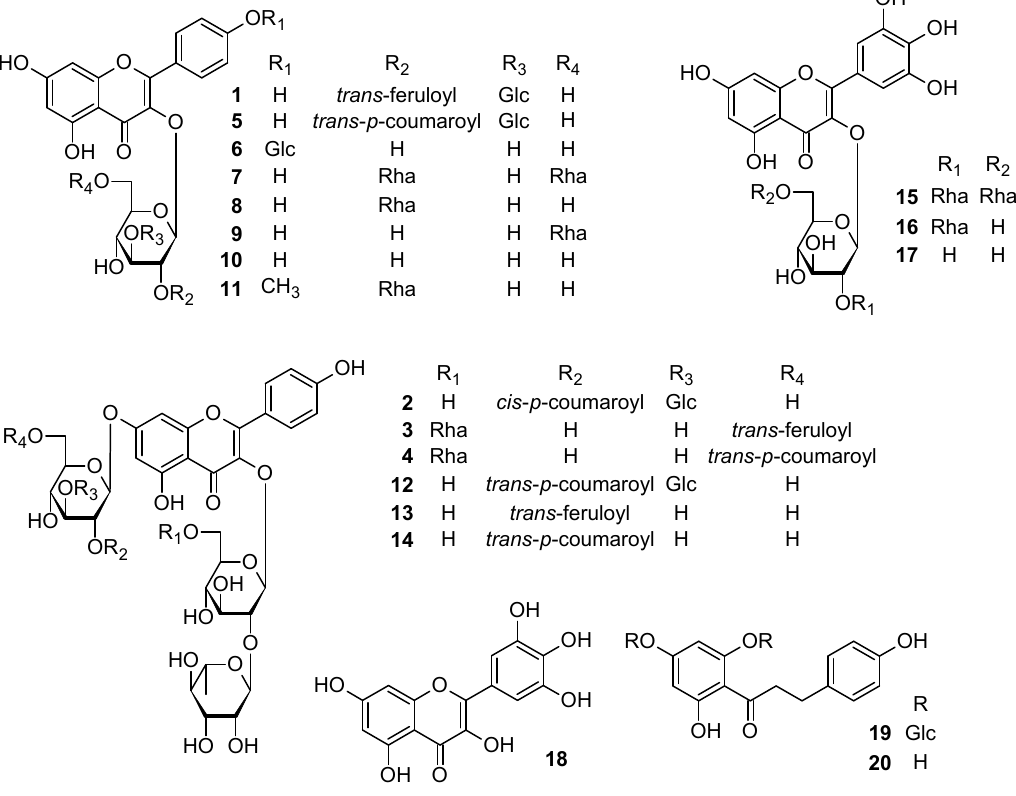
Figure 1. Compounds 1 – 20 isolated from Cadaba rotundifolia .